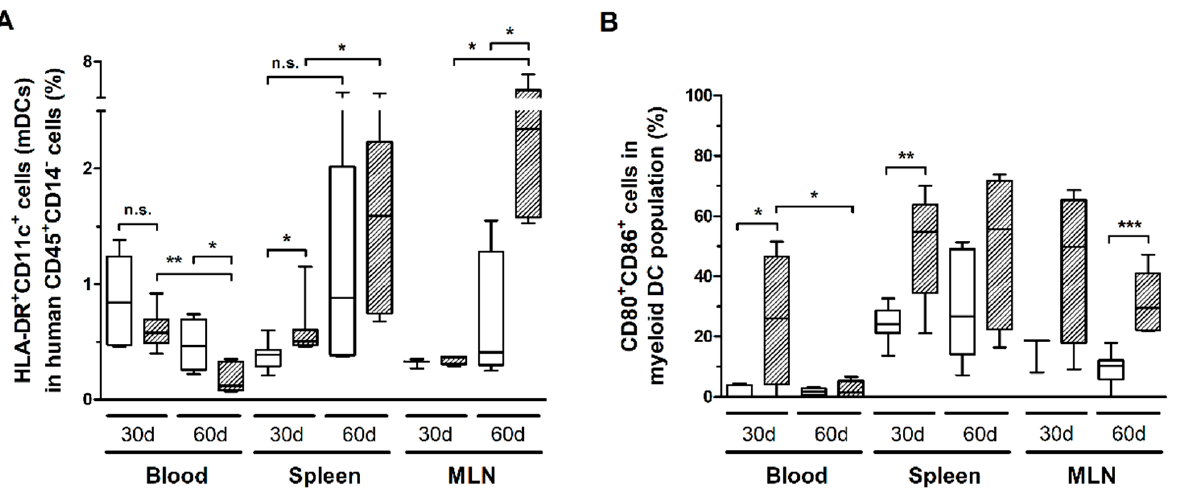
Figure 7. Frequency of myeloid dendritic cells and the expression of co-stimulatory molecules. Blood, spleen, and mesenteric lymph nodes (MLN) from HTLV-1-infected (dashed box) and control HIS-NSG mice (white box) were collected at 30 days and 60 days from inoculation. ( A ) The frequency of myeloid dendritic cells (mDCs), which were identified as HLA- DR + CD11c + cells, was determined in the gate of CD45 + CD14 − cells. ( B ) Frequency of CD80 + CD86 + cells is shown within mDCs. Statistical analysis was performed with Student’s t -test (n.s., non-significant; *, p < 0.05; **, p < 0.01; ***, p < 0.001). Control groups 30 d and 60 d: n = 7; HTLV-1-infected group 30 d: n = 8; HTLV-1-infected group 60 d: n =